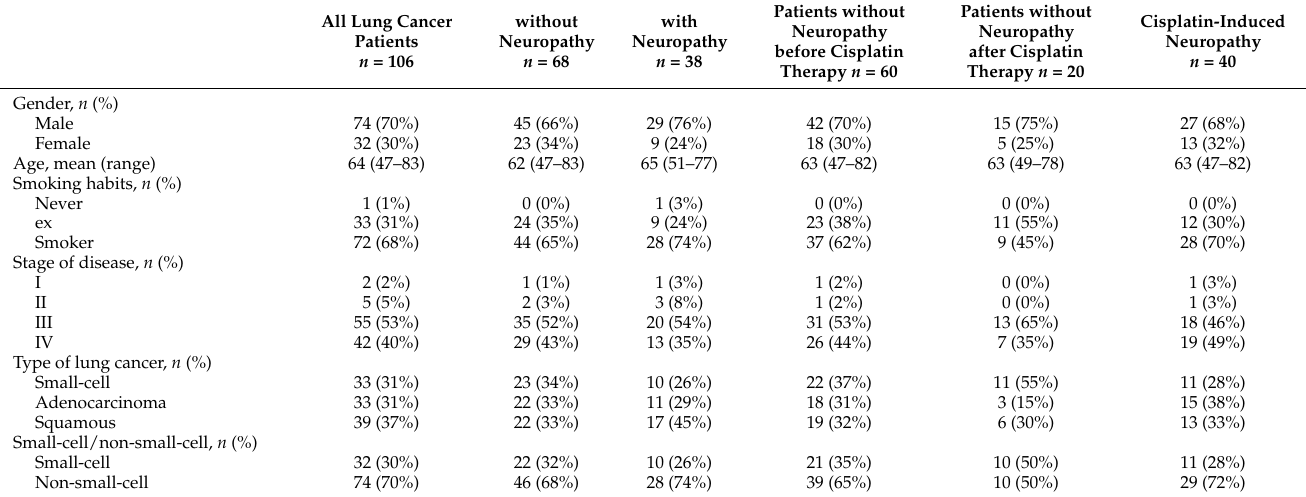
Table 1. Characteristics of study